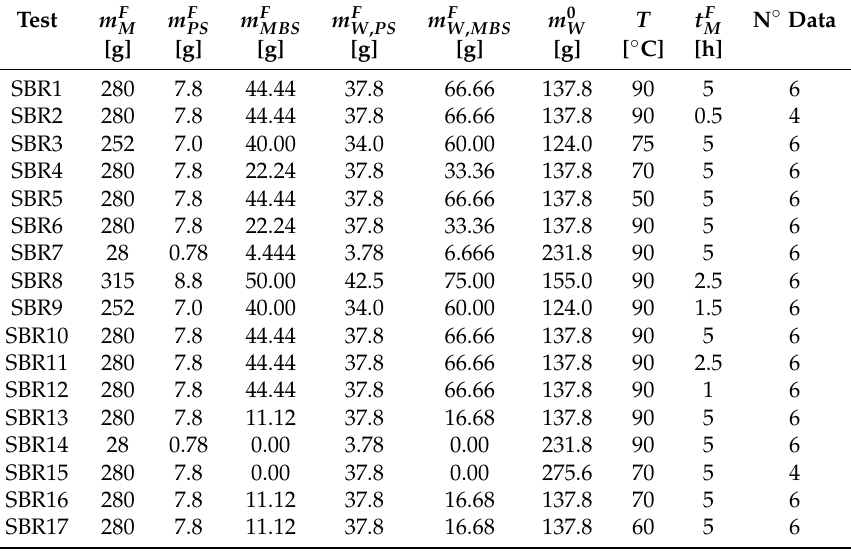
Table 1. Settings of the SBR tests and available number of specimen over time for each